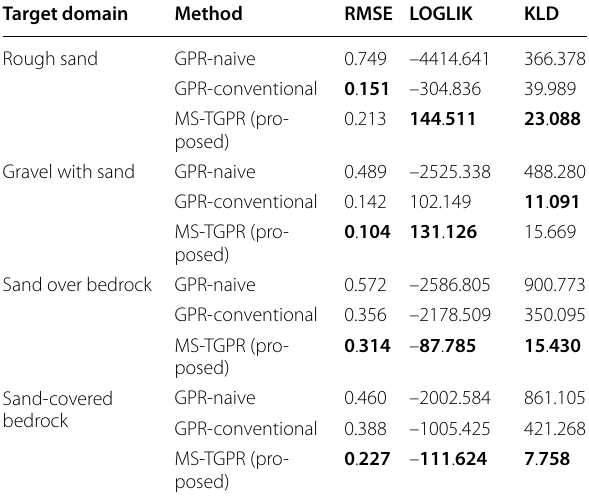
Table 3 RMSEs, LOGLIKs, and KLDs of slip models learned in Evaluation 1. Bold numbers indicate best results among the three methods for each target domain